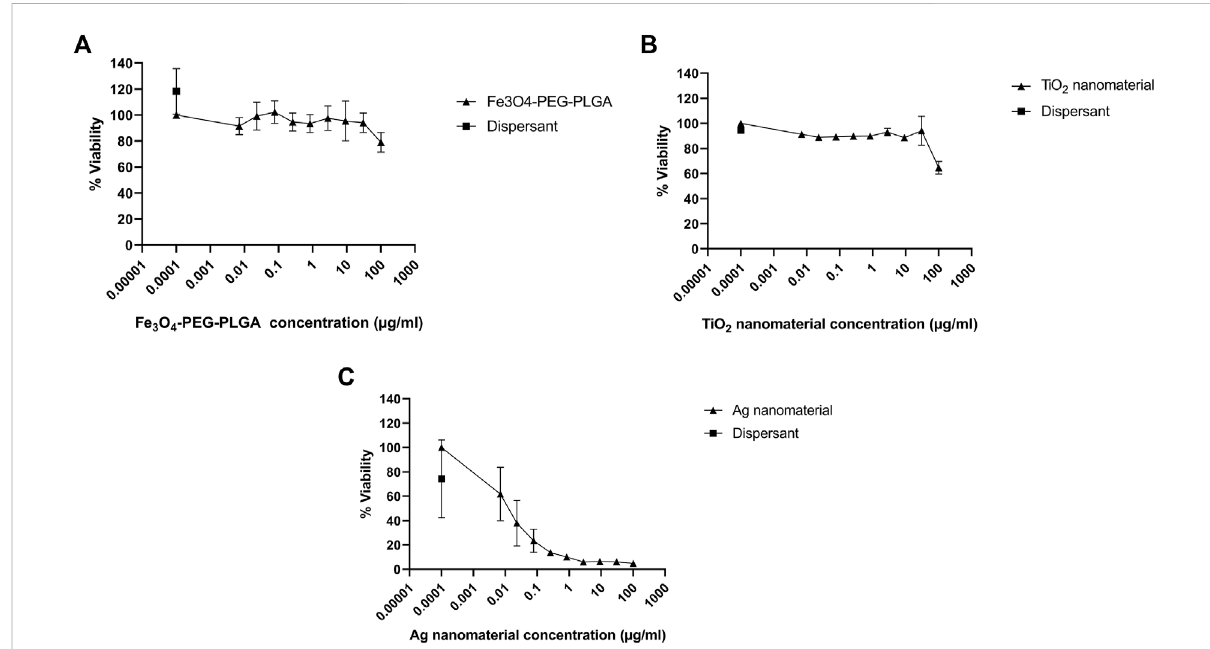
FIGURE 3 Cytotoxicity assessment. U2OS cells were exposed for 24 h to (A) Fe 3 O 4 -PEG-PLGA, (B) TiO 2 nanomaterials, and (C) Ag nanomaterials or dispersants and cell viability (metabolic capacity) was evaluated using the Alamar blue assay. Data are mean values ± S.D. of three independent experiments.